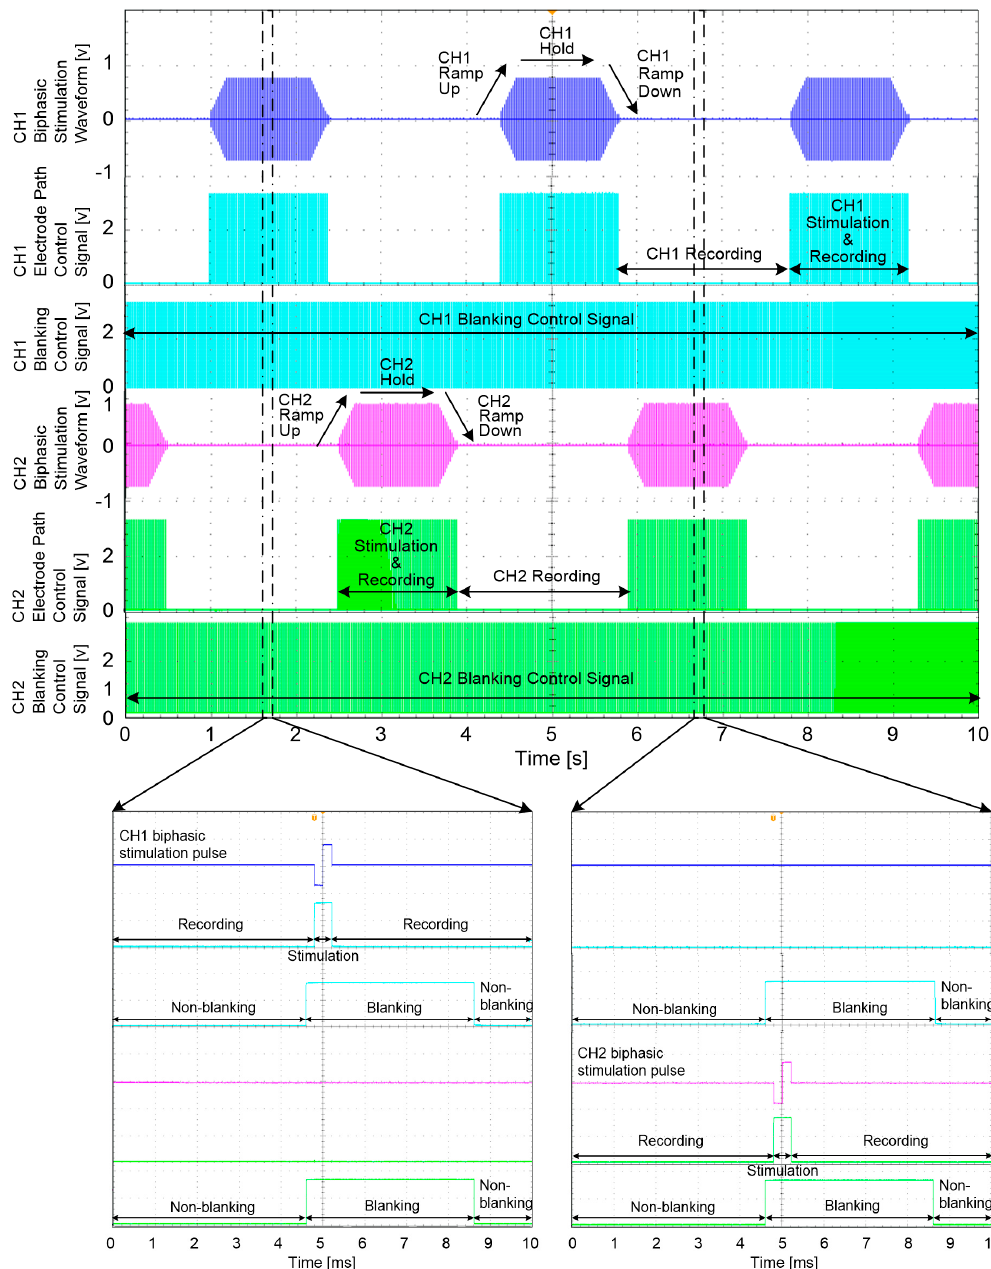
Figure 15. Stimulation waveforms and control signals for the cuff-electrode path controllers and blanking